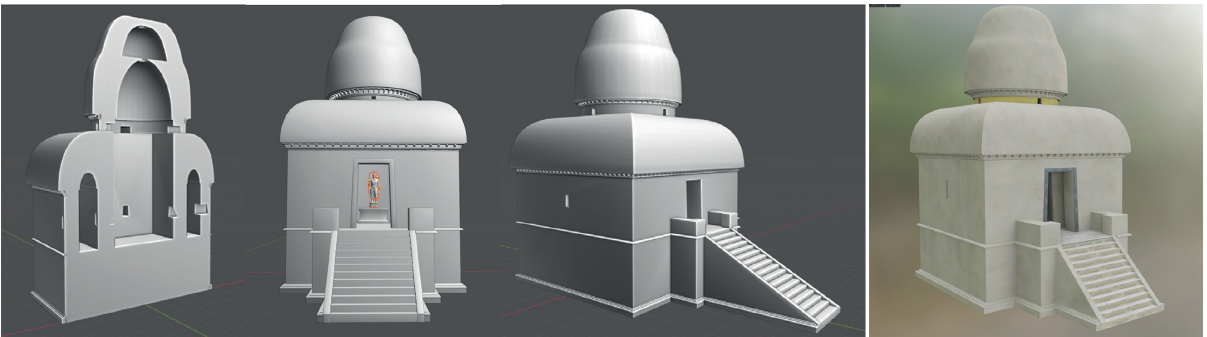
Figure 12 . The mannequin posing and the integration of the forearms, referring to standing Buddha at The Metropolitan Museum of Art, New York, U.S.A.